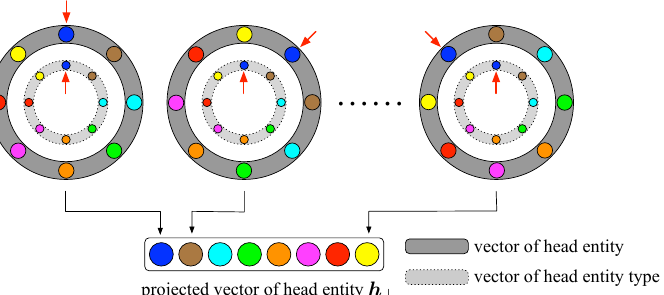
Figure 3. Illustration of the mapping function. The annulus in dark grey represents the vector of head entity, while the annulus in light gray represents the vector of head entity